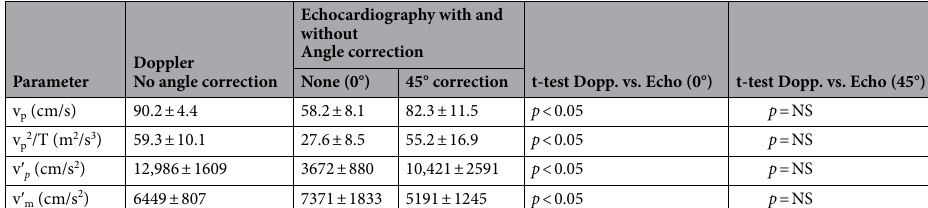
Doppler No angle